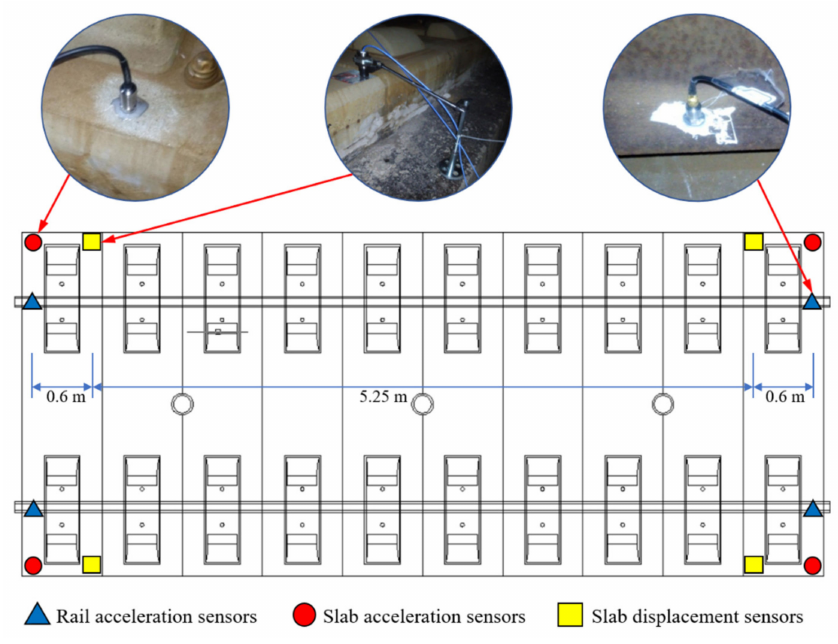
Figure 10. Sensor location diagram. Table 2. The sensor